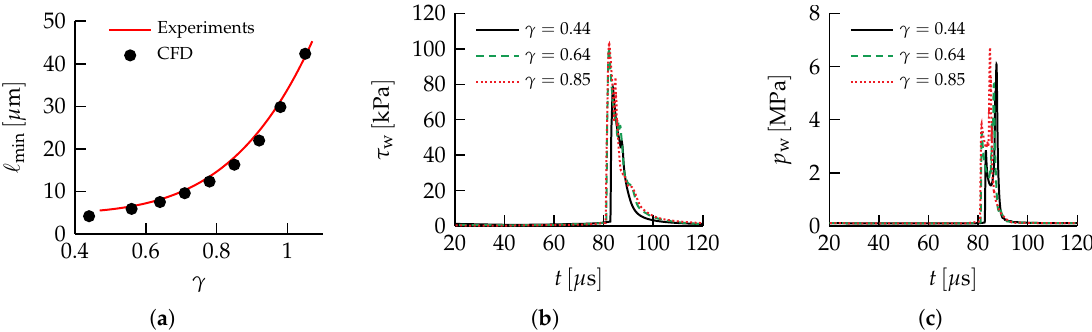
Figure 6. Wall-bounded cavitation. ( a ) Results of the minimum liquid film thickness (cid:96) min as a function of the dimensionless stand-off distance γ = (cid:96) 0 / R max obtained with the proposed algorithm, compared against the correlation (cid:96) min = 29.2 µ m γ 4.86 + 4.74 µ m obtained by experimental measurements in the range γ = 0.47 − 1.07 [51]. ( b , c ) Evolution of the maximum wall shear stress τ w and maximum wall pressure p w , respectively, for selected stand-off distances γ